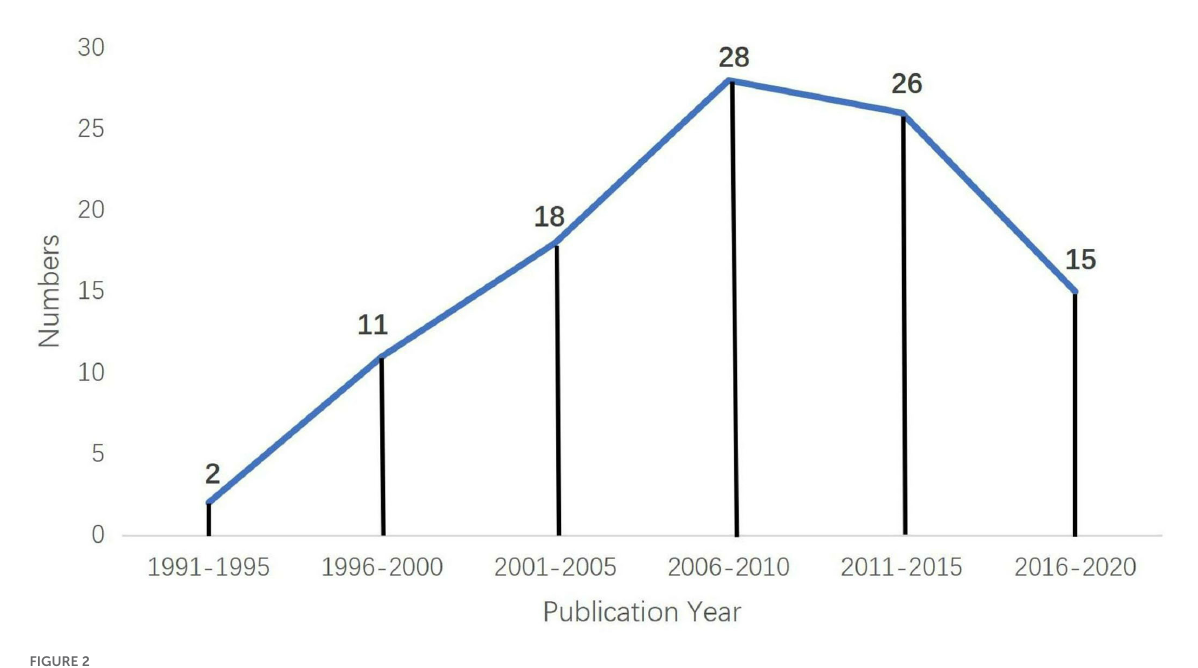
FIGURE2 Distribution of the top 100 articles in each 5-year